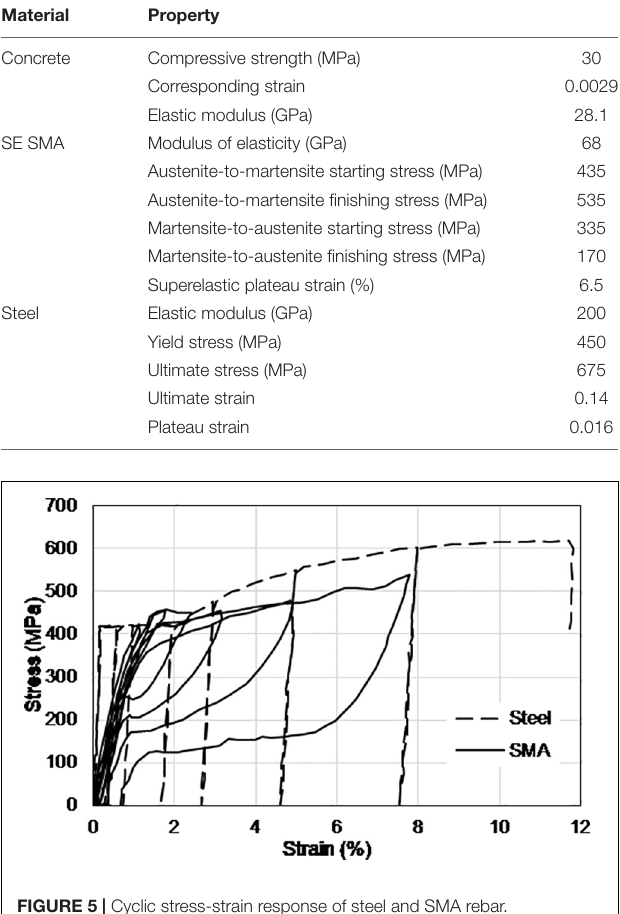
rebar. As suggested by Priestley et al. (1996), concrete spalling is expected to start at a strain of 0.004. Crushing of core concrete represents significant strength degradation which typically occurs when confined concrete strain is between 0.015 and 0.05